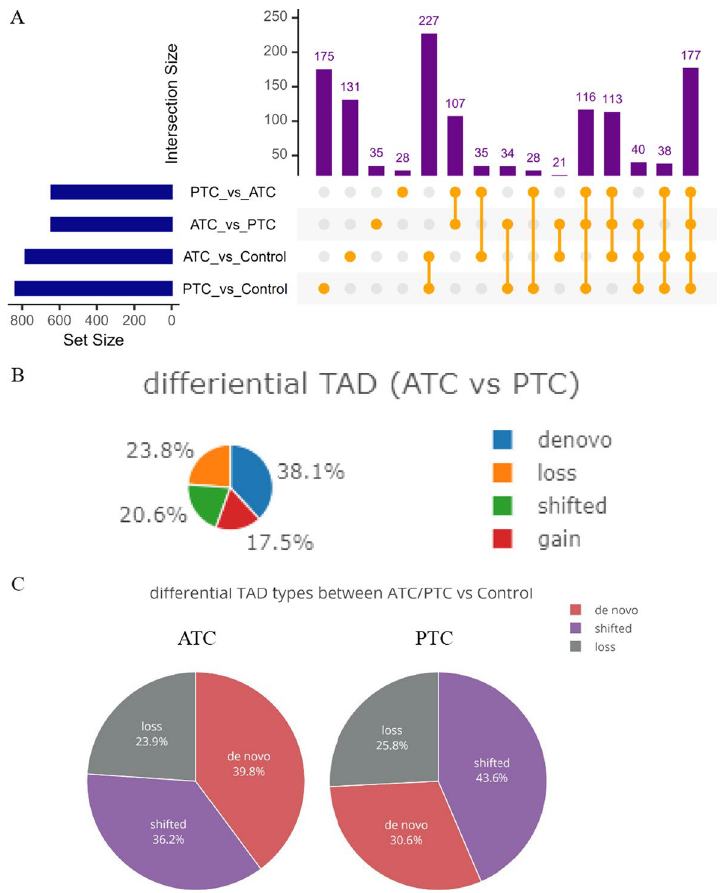
Fig. 6 A – C Differences in TAD changes between ATC, PTC, and normal thyroid cell lines. A Comparison of differential TAD blocks among ATC, PTC, and normal cell lines; B TAD changes (de novo, loss, shifted, and gain) between ATC and PTC cell lines; C Global TAD changes (de novo, shifted, and loss) in ATC and PTC versus